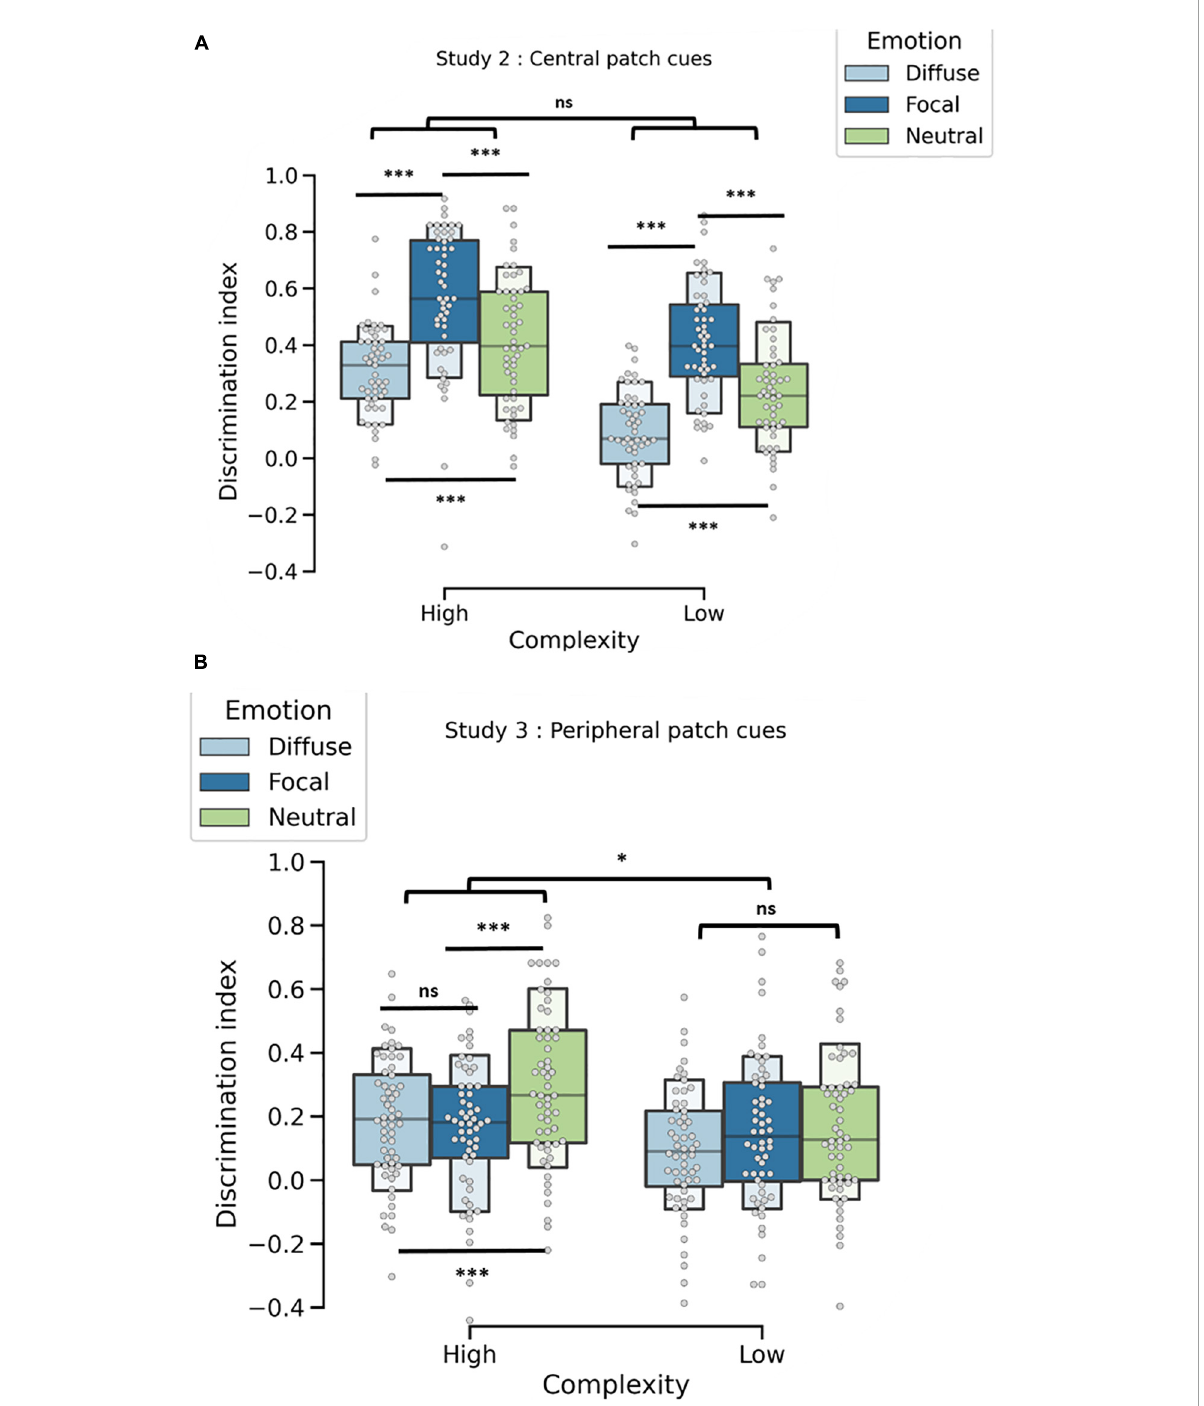
FIGURE4 (A) Discrimination index (d-prime) as a function of emotional content (diffuse, focal, or neutral) for Study 2, where patch cues were centered on the emotion. Focal conditions were systematically better recognized than were mean diffuse and neutral conditions. Diffuse conditions were less well remembered than neutral conditions. High-complexity conditions were also better recognized than low-complexity conditions, but emotion and complexity did not interact. (B) Discrimination index (d-prime) as a function of emotional content (diffuse, focal, or neutral) for Study 3, where patch cues were not centered on the emotion. In contrast to Study 2, focal conditions in Study 3 were not better recognized than the other conditions. This difference is in line with the trade-off effect, in which peripheral information is less well encoded than central information when emotional and neutral content are in competition. Recognition was also better for high-complexity conditions than for low-complexity conditions. The interaction between emotion and complexity was held by the neutral condition. No effect = ns; * p < 0.05; *** p <